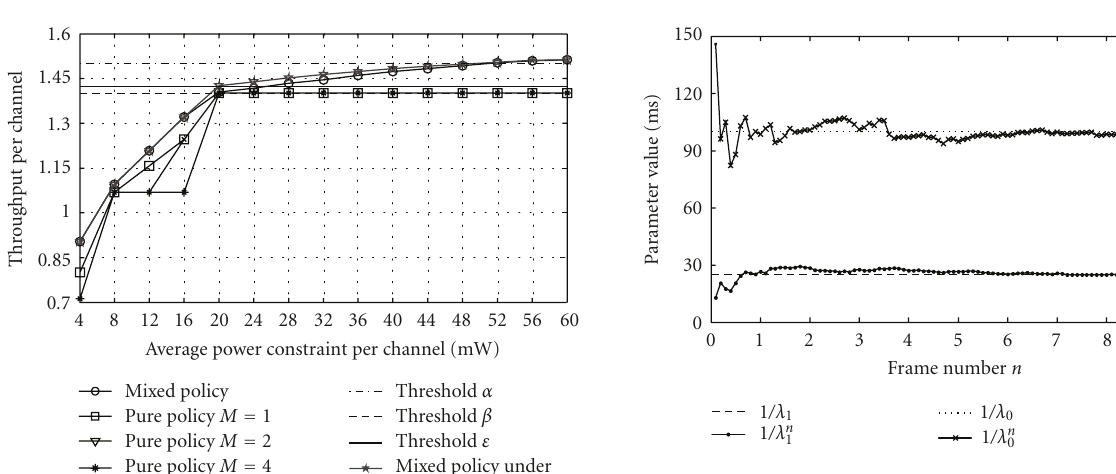
Figure 6: Parameter pair estimation without prior